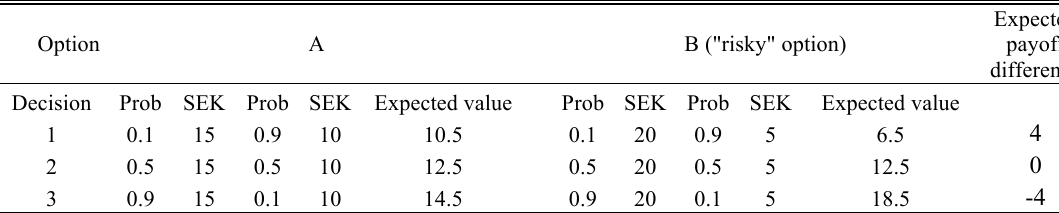
Table A4.1. Comparison of the four risk game treatments in terms of expected values and payoff differences. Prob means probability.